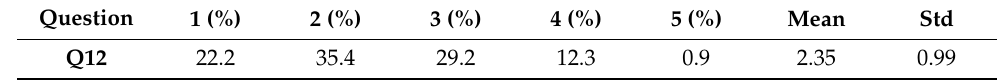
Table 7. Di ffi culty of filling out the reporting form—descriptive statistics.